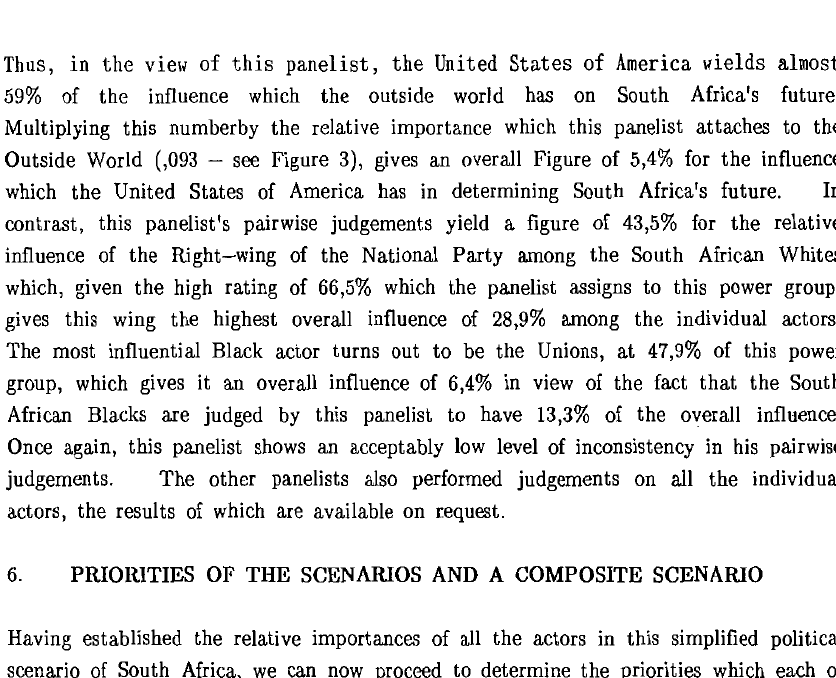
RELATIVE PRIORITIES OF THE FIVE FUTURE SCENARIOS FOR SOUTH AFRICA FROM THE VIEWPOINT OF EACH OF THE